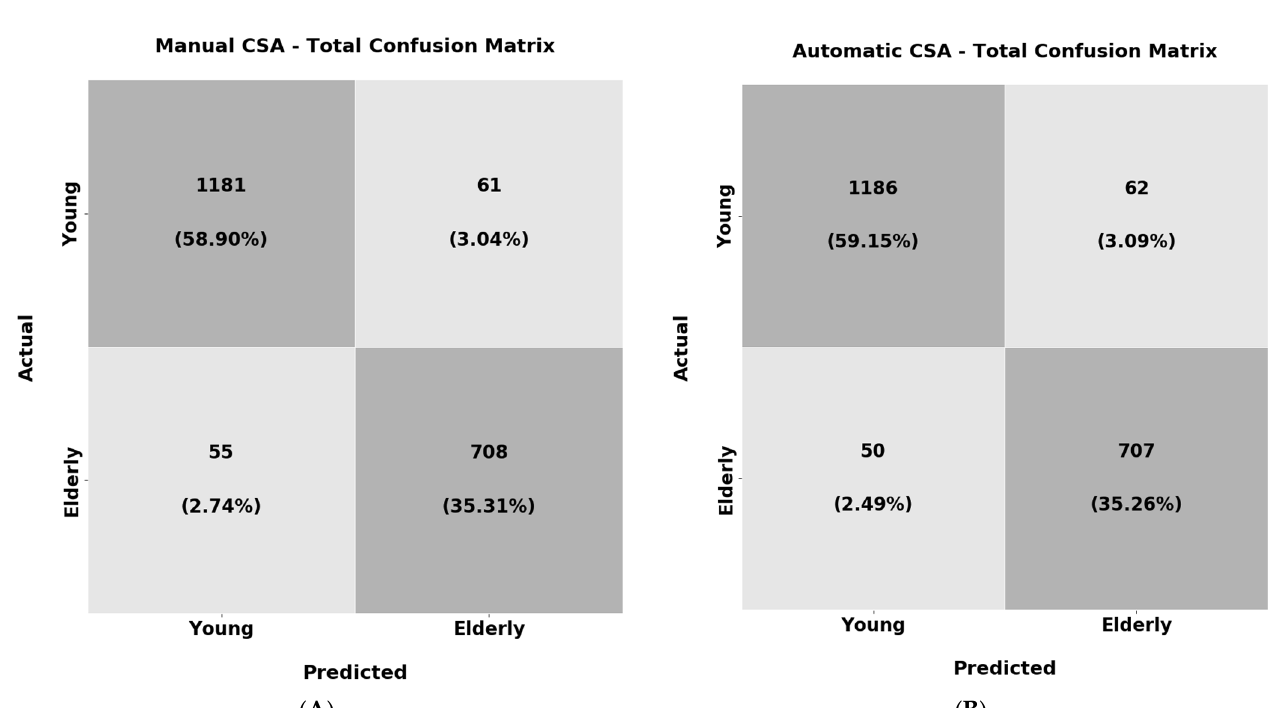
Figure 16. Confusion matrices for the young vs. elderly subjects’ analysis. In ( A ), the manually extracted CSA texture was used and in ( B ), the automatic was used.